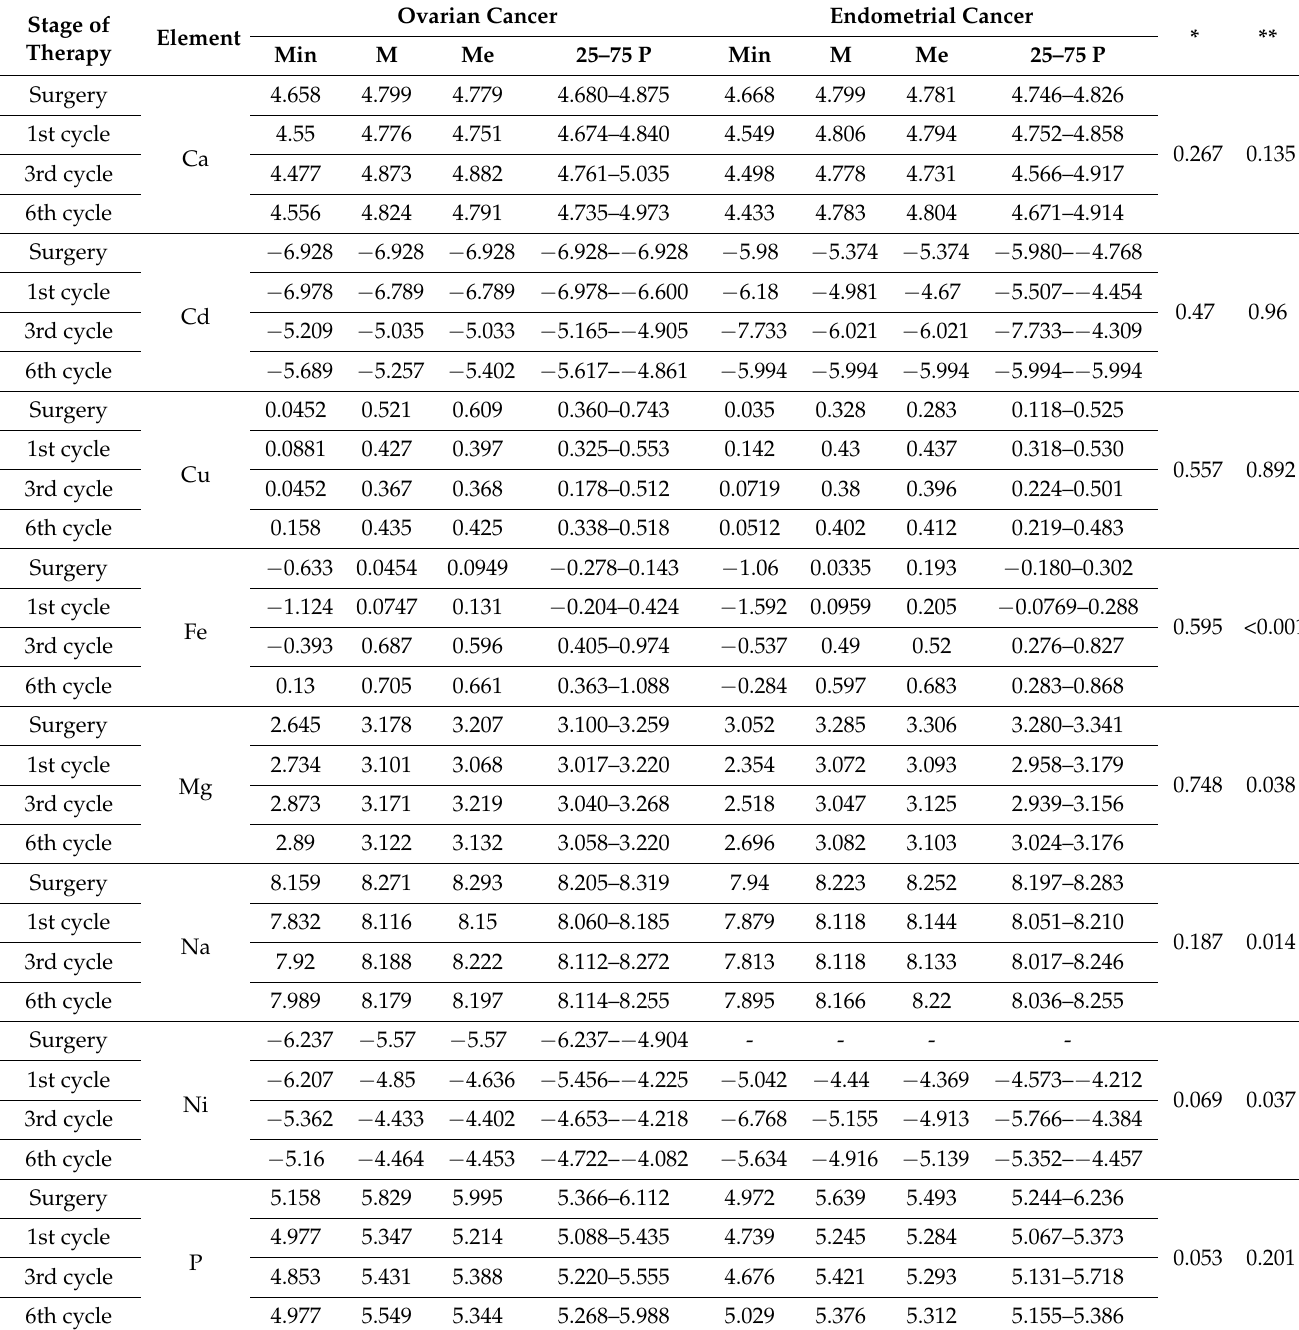
Table 3. The relationship between the levels of the tested elements, the stage of therapy, and the type of